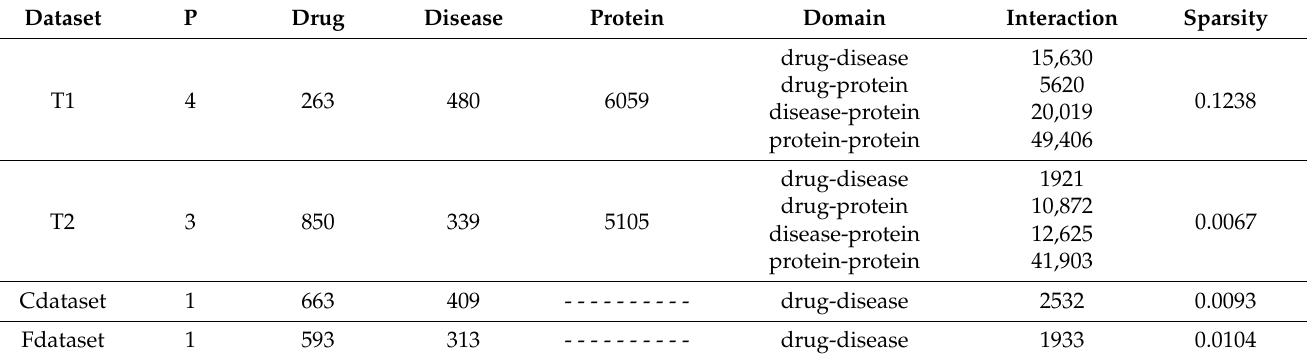
Table 1. Data information on our network construction for drug